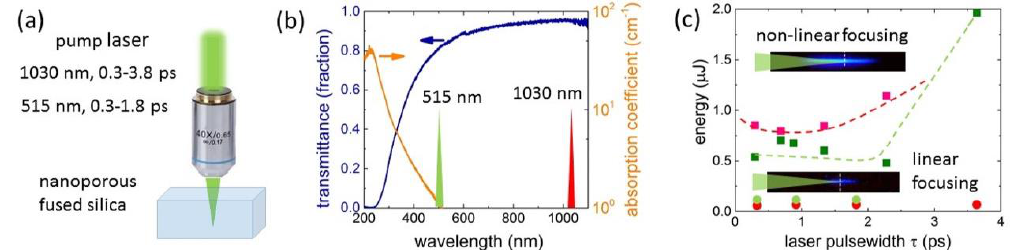
Figure 1. ( a ) Schematic of the laser setup. ( b ) UV-near-IR transmittance and absorption coefficient spectra of the np-FS sample. ( c ) Critical energy values P cr τ for non-linear focusing (Kerr self-focusing) in np-FS versus τ at 1030 nm (red squares and dashed curve) and 515 nm (green squares and dashed curve) wavelengths in comparison to the maximal pulse energy values used in the study (bottom red and green circles). Inset: side-view visualization of linear and non-linear focusing via blue recombination plasma